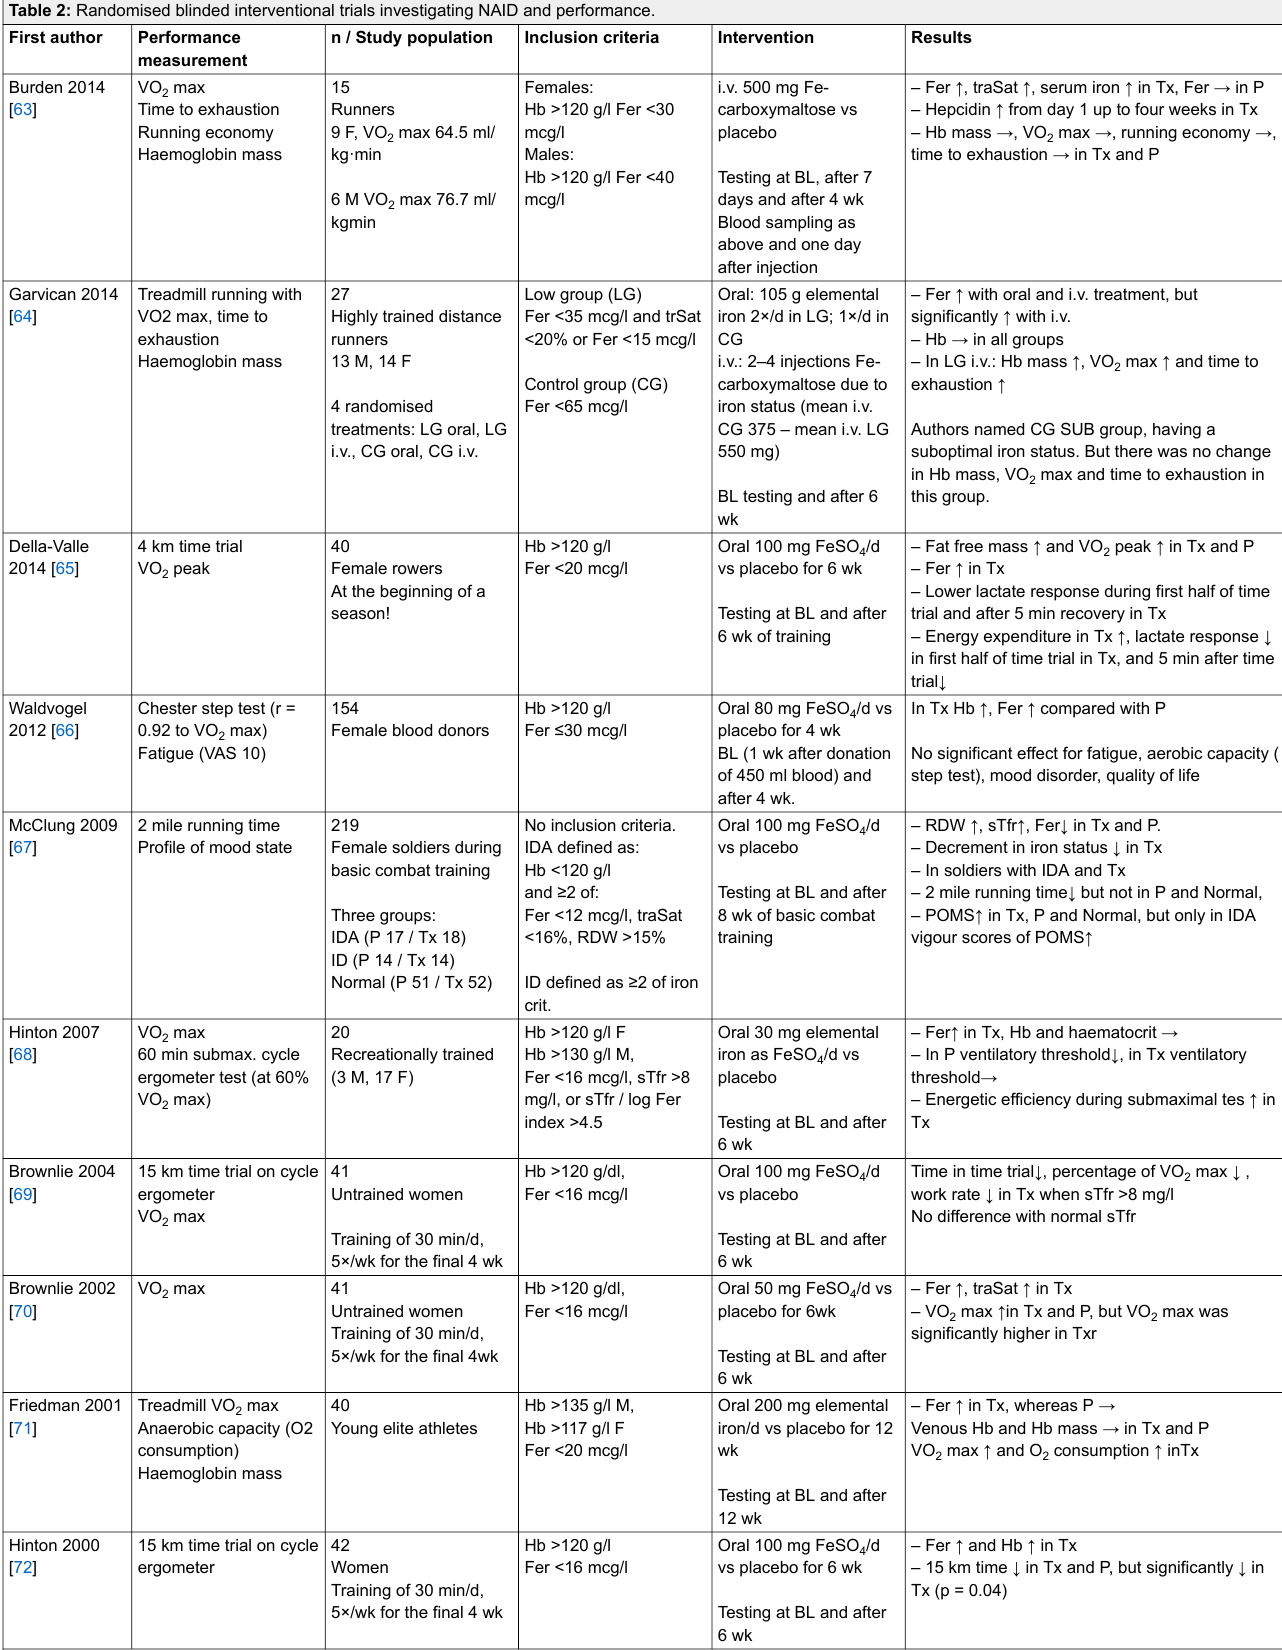
Table 2: Randomised blinded interventional trials investigating NAID and